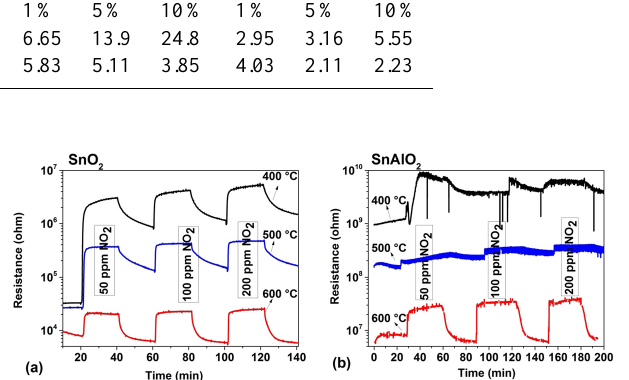
Table 3. Comparison of recovery times for SnO 2 and SnO 2 :Al sensing layer towards 1, 5 and 10% RH (without NO 2 exposure). T w ( ◦ C)